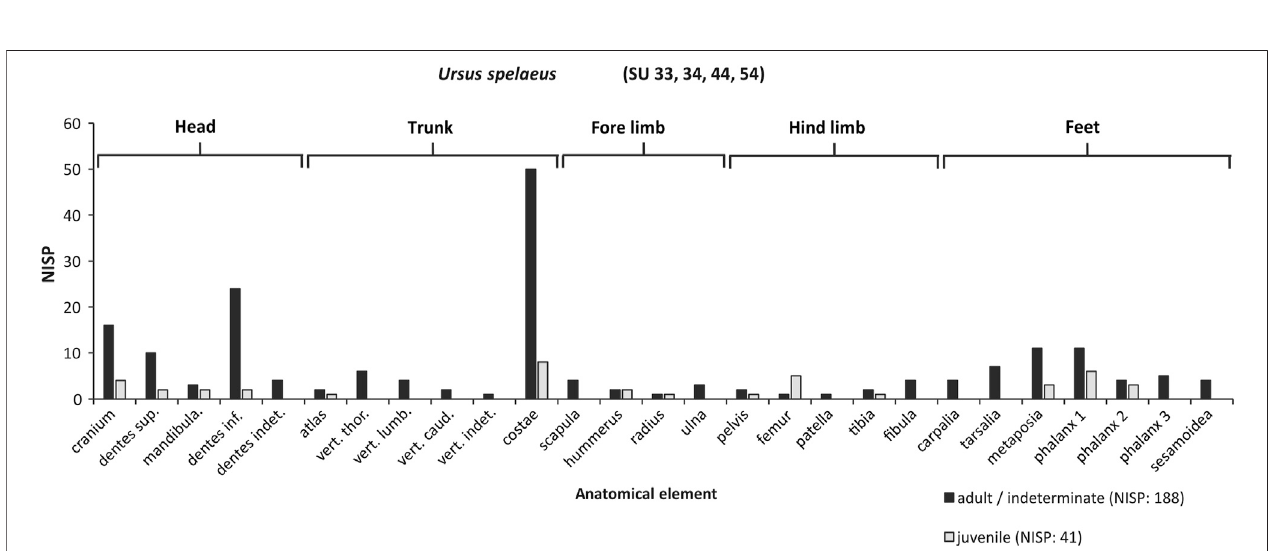
FIGURE 8 | Body part representation (NISP) of Ursus spelaeus at the pro fi le DC-SP in the Lower Cerova ˇ cka Cave, presented separately for two main age categories. A single fetal/neonatal bone has been excluded.